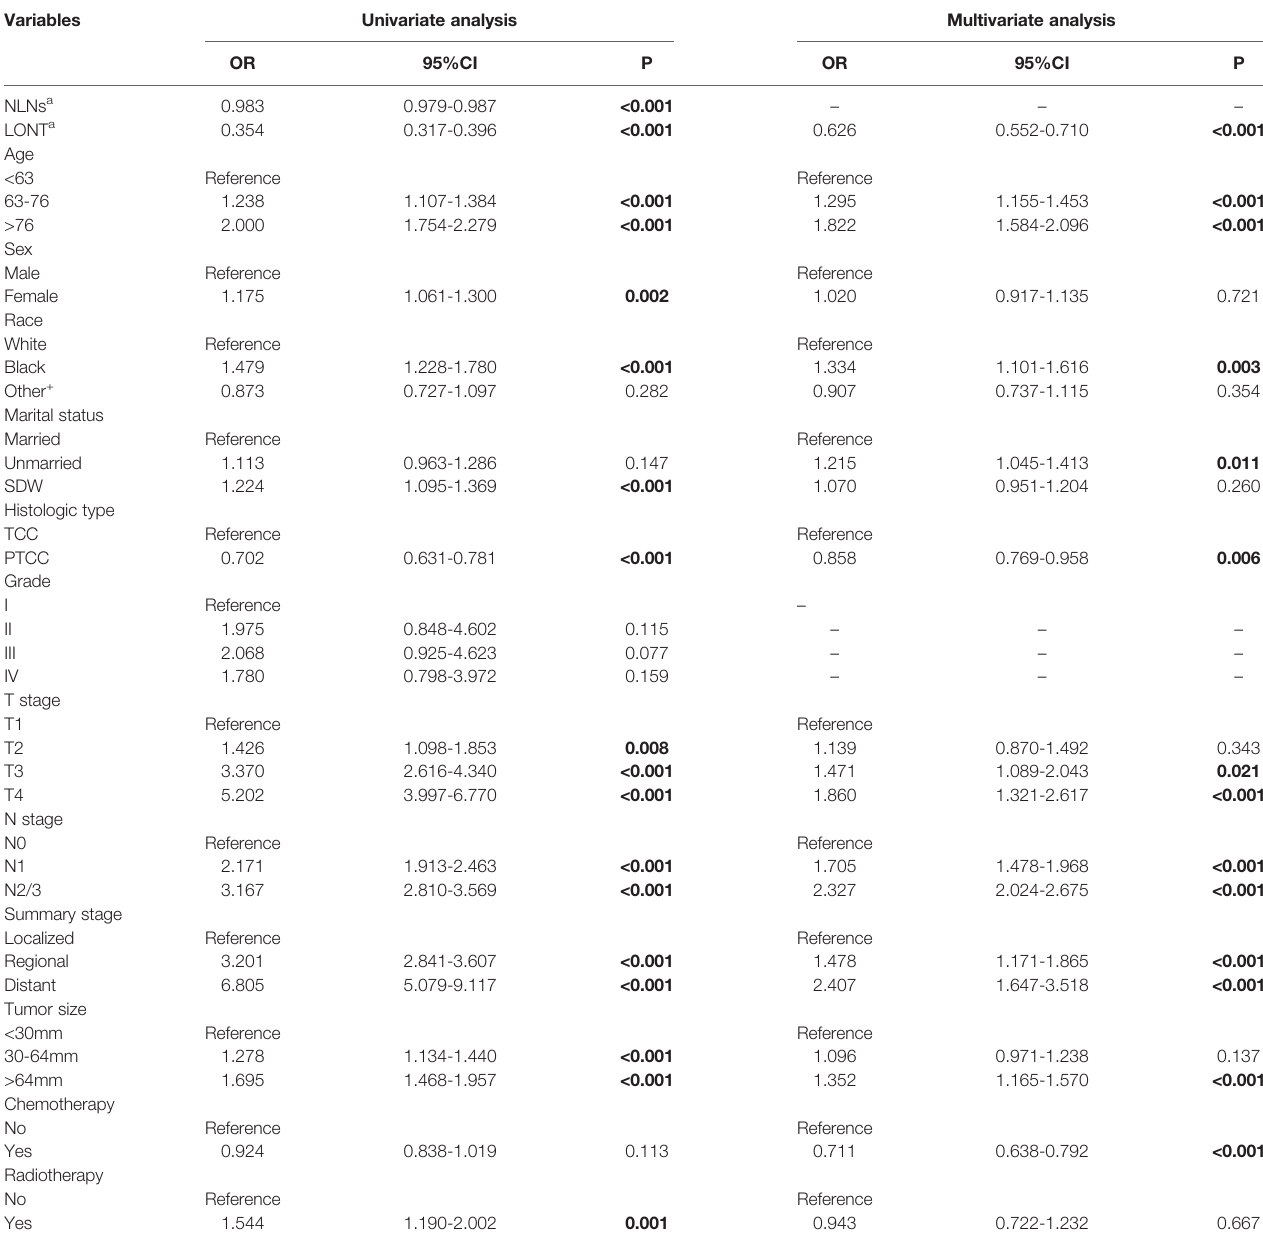
TABLE 3 | Univariate and multivariate Cox regression analyses for overall survival in the primary